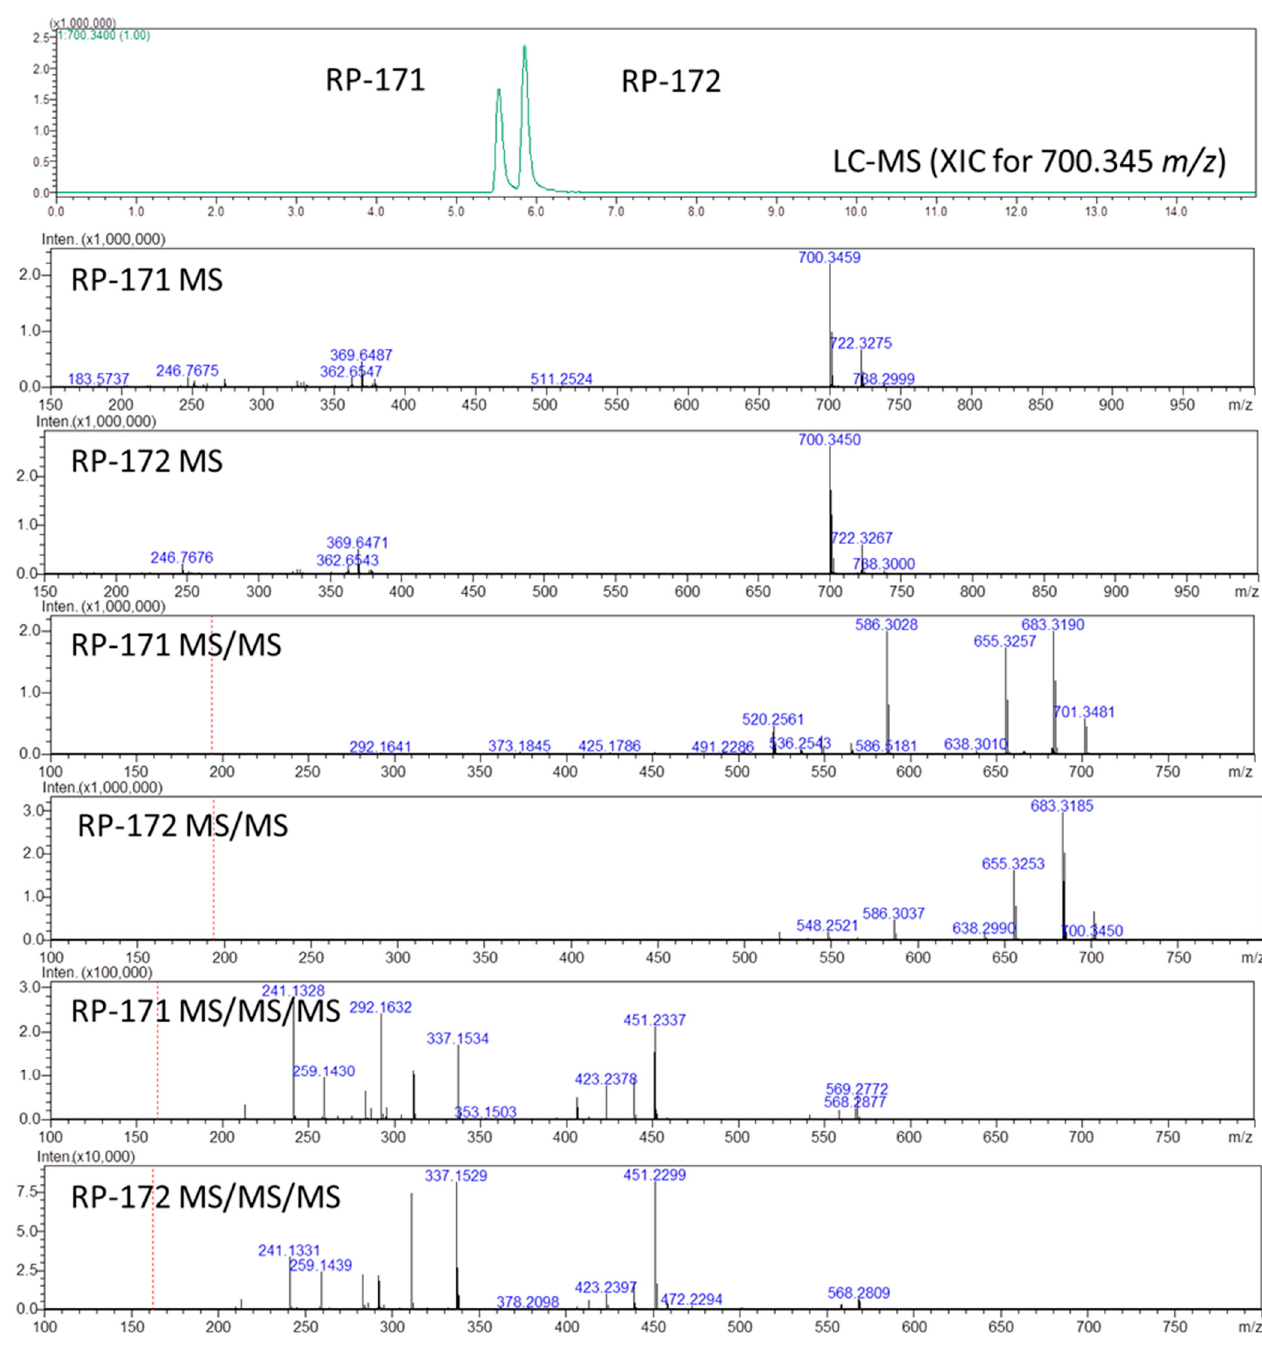
Figure 2. LC-MS n analysis of peptides RP-171 and RP-172 . Extracted ion chromatogram (XIC) showing two peaks for the mixture of peptides (top panel): MS panels, all spectra recorded for the retention time of indicated peaks; MS spectra, MS/MS spectra for the precursor ions m / z 700.34, and MS/MS/MS spectra for the precursor ions m / z 586.30.